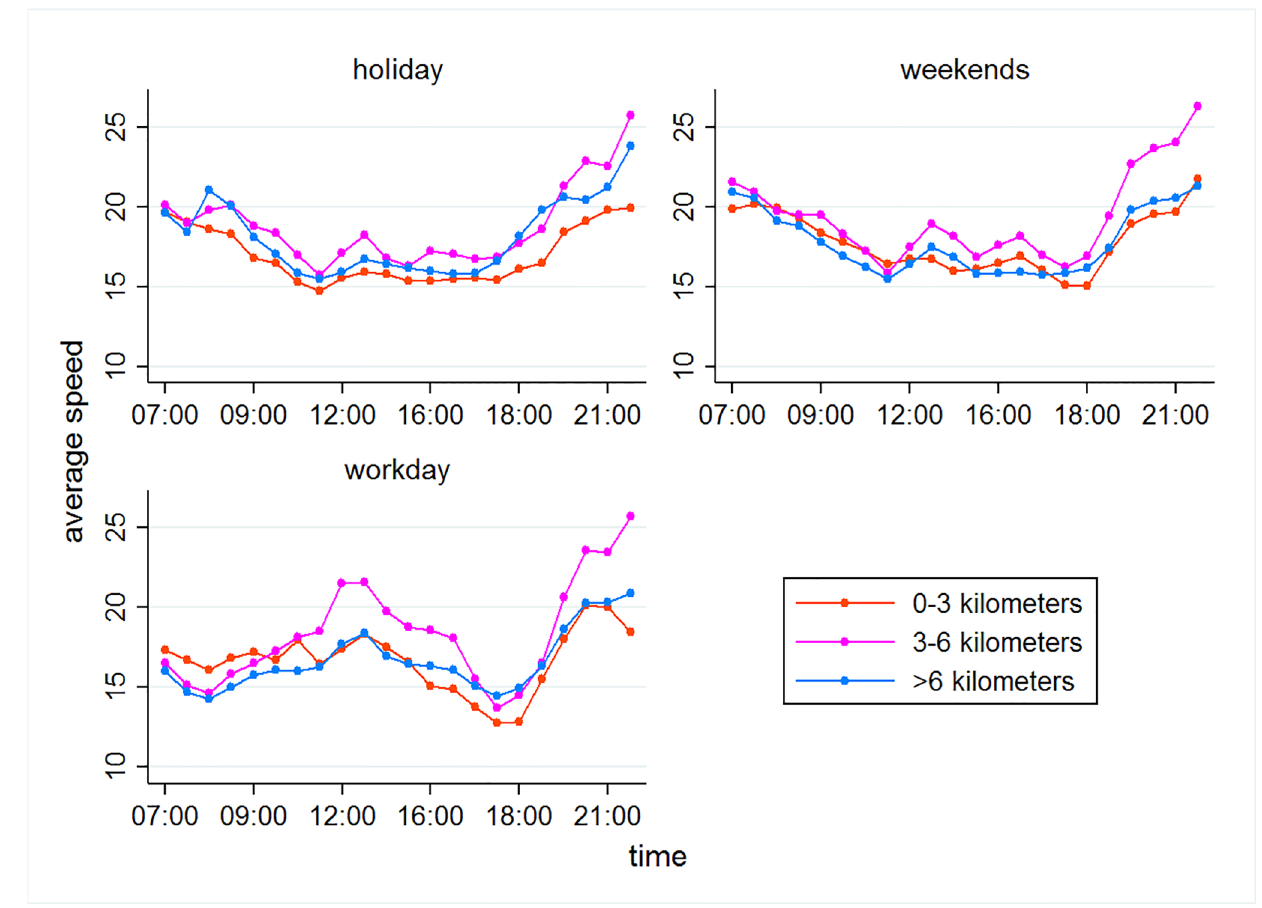
Fig 1. Daily changes in travel